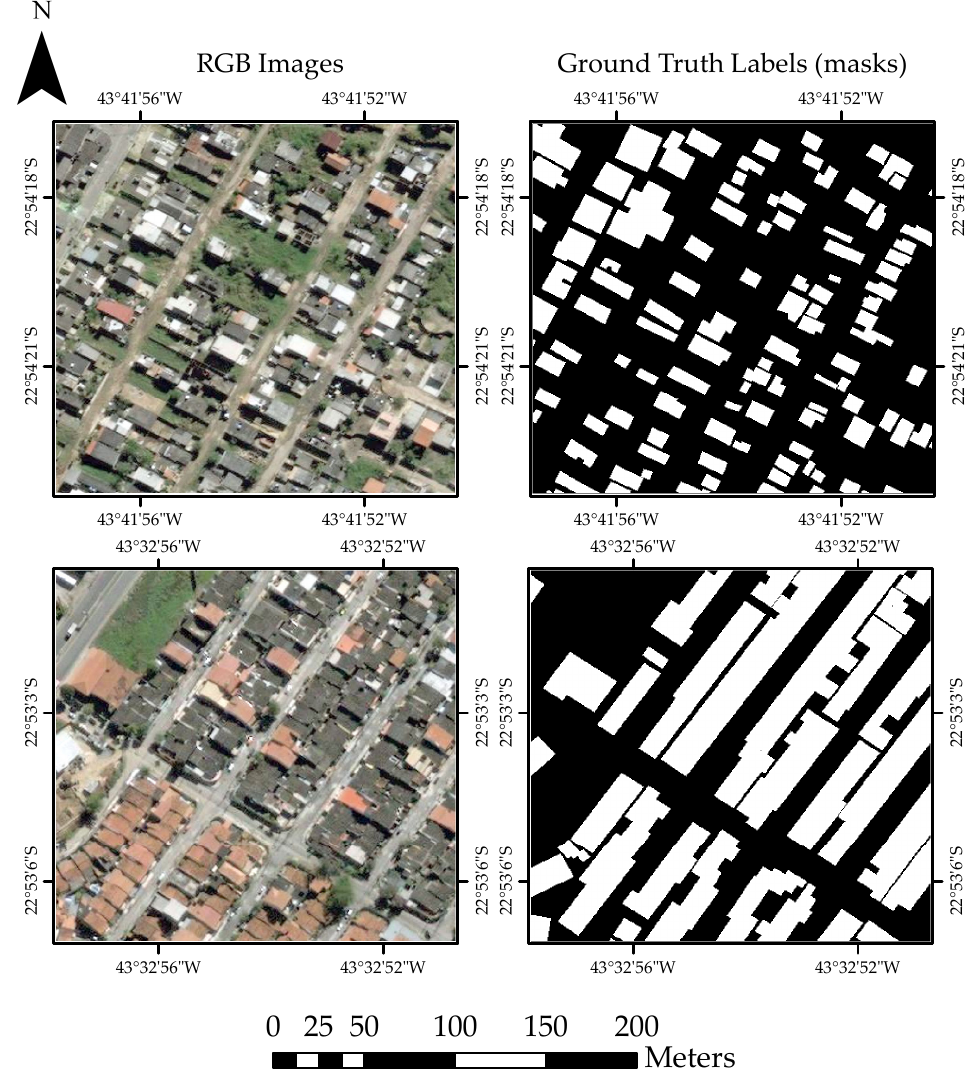
Figure 4. Two sample images taken from the WorldView-2 satellite along with their masks from the SpaceNet 1 dataset. ( Left ): RGB image patches. ( Right ): Corresponding